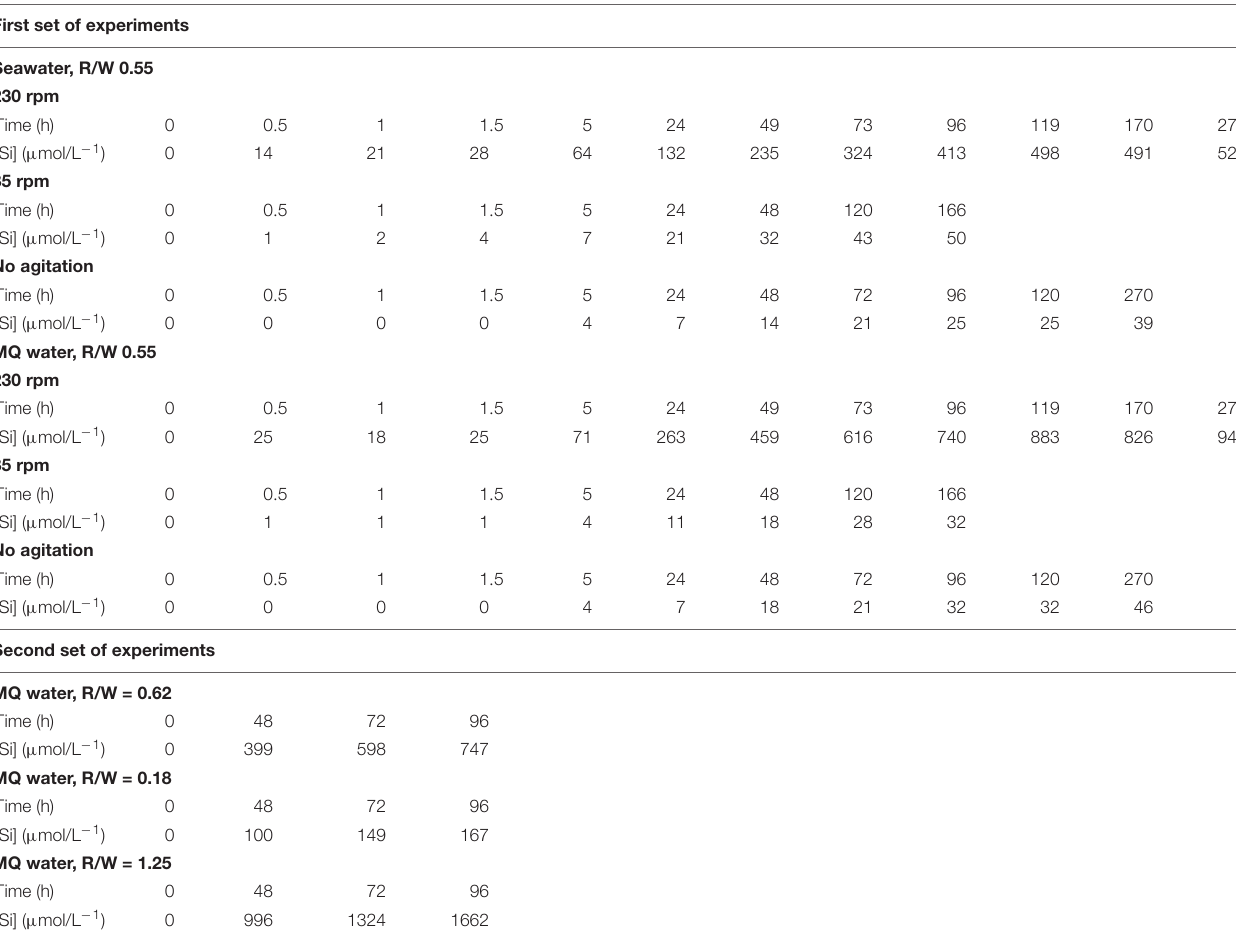
TABLE 2 | Experimental